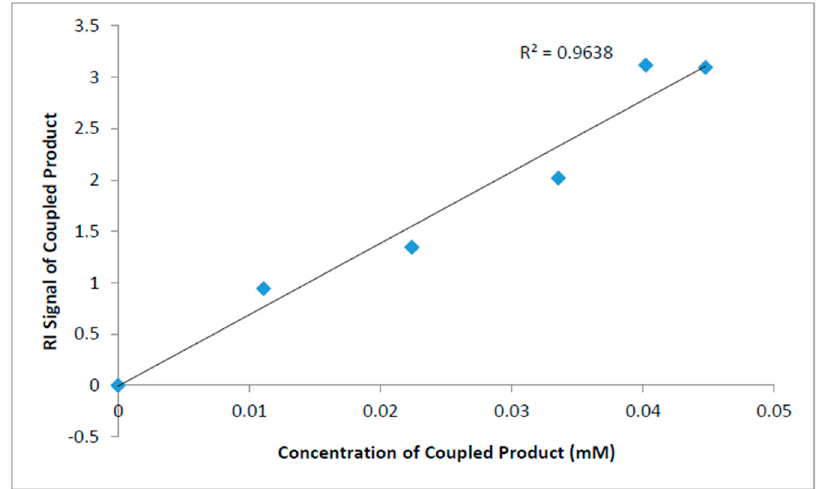
Figure 5. RI signal of GPC-RI detector (Wyatt T-rEX) of M p assigned to “coupled” peak of polymer mixture (nominal molecular weights 17,500 and 50,000 Da), as a function of concentration in the mixture injected into GPC.